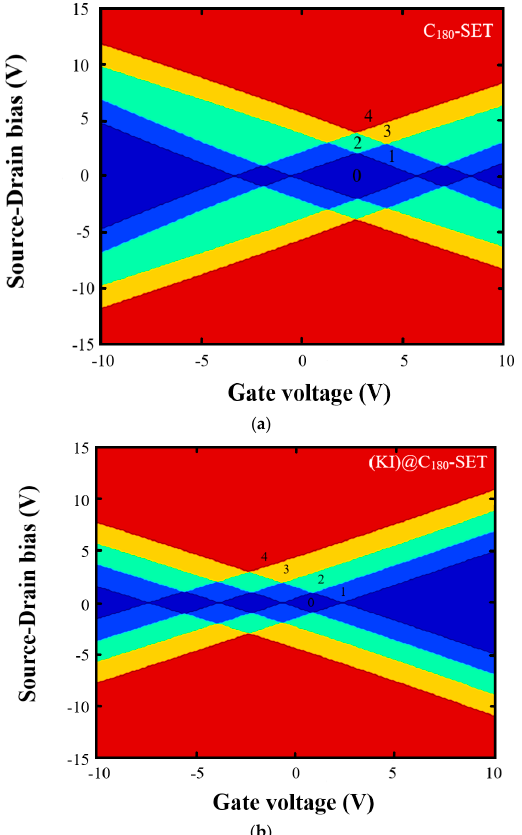
Figure 4. Charge stability diagrams for SETs—( a ) C 180 ; ( b ) (KI)@C 180 . The number of charge states for given bias potentials are represented by the following colors: blue (0), light blue (1), green (2), yellow (3), and red (4).